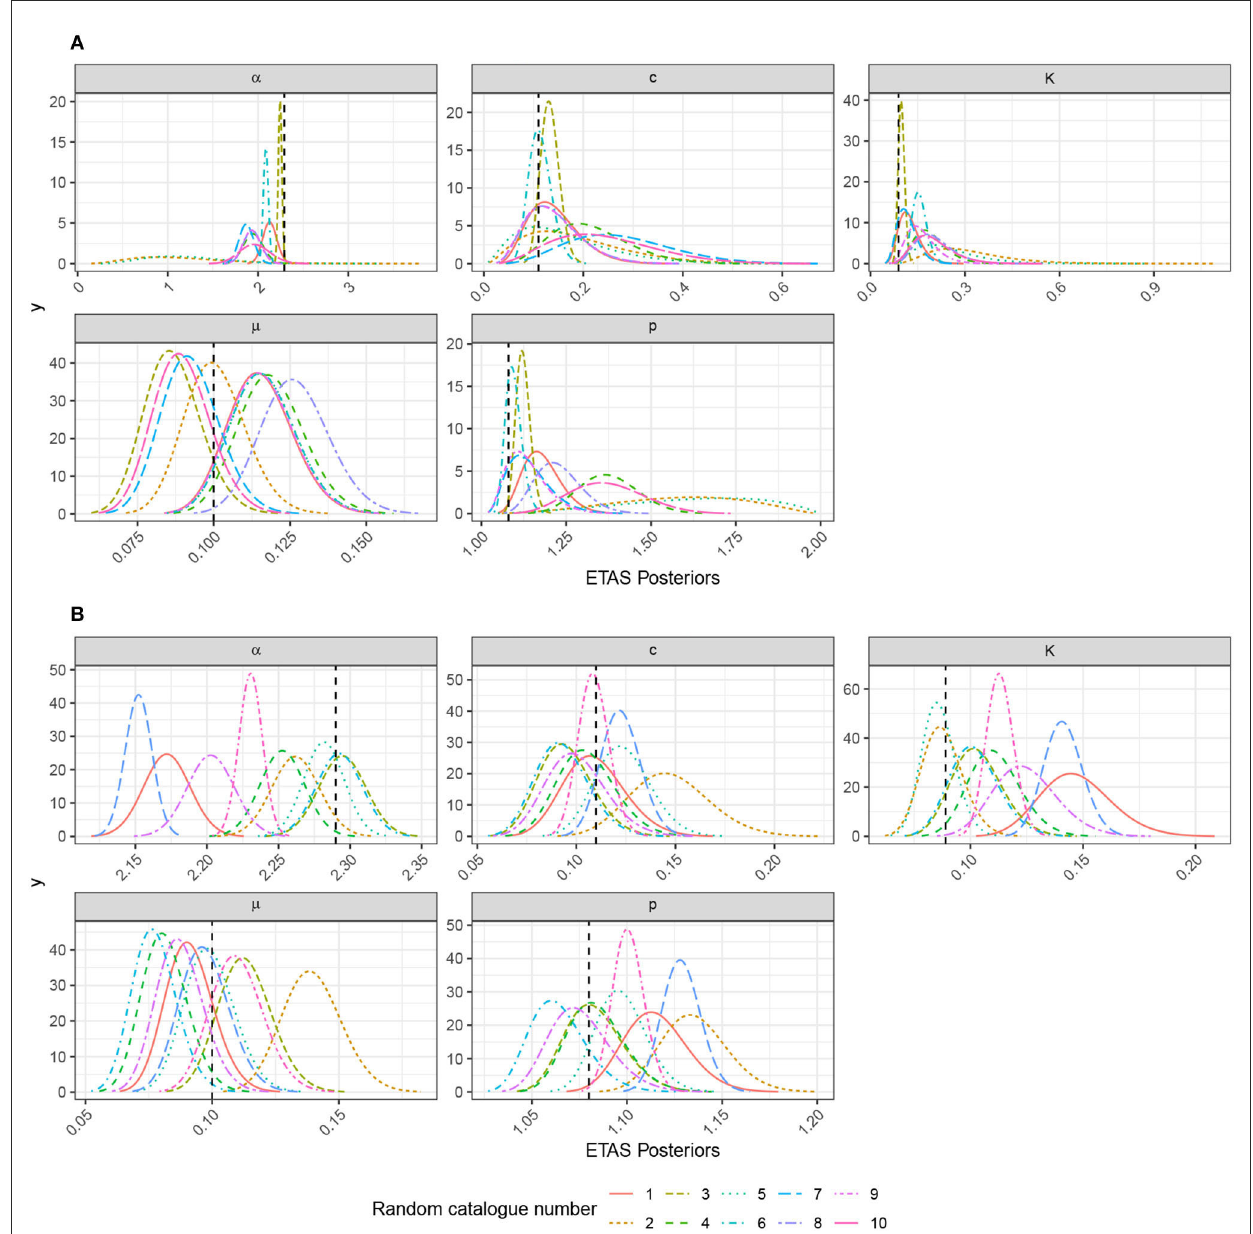
FIGURE8 Posteriors that explore the impact of stochastic variability on the inverted ETAS parameters using inlabru . These are based on the relatively quiet catalogs in Figure 6 and those with a large event seeded on day 500 in Figure 7. The catalog numbers can be cross-referenced between the figures. (A) Impact of stochastic variability for 1,000-day catalog with no large events seeded. (B) Impact of stochastic variability for 1,000-day catalog with an M6.7 event seeded on day